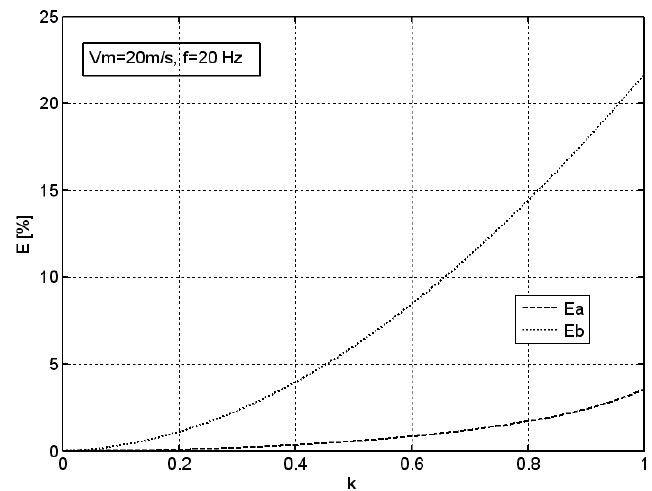
Figure 6. Effect of the coefficient of modulation k of sinusoidal excitation on the error of average velocity measurement E for both measuring systems, v m = 20 m/s, f = 20 Hz.